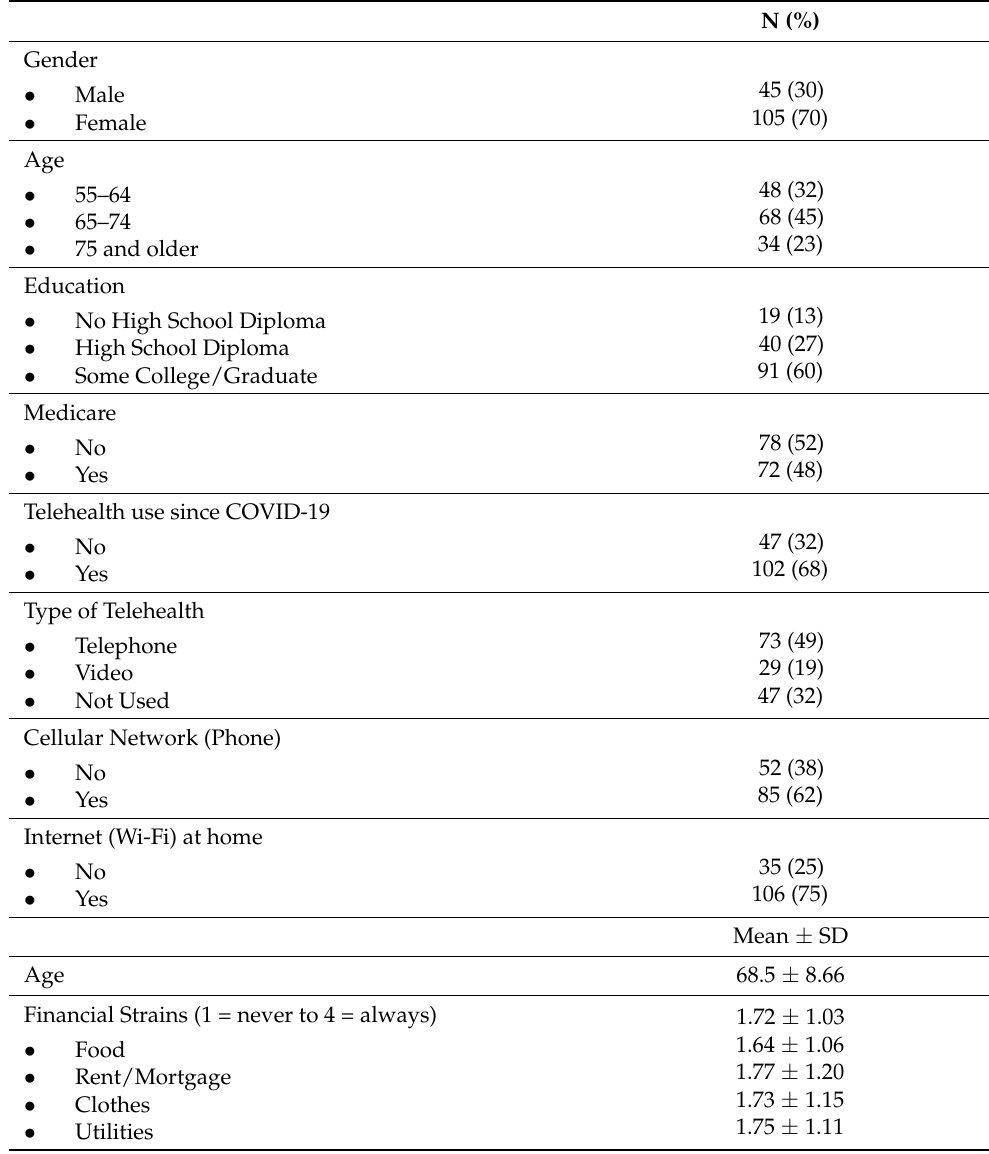
Table 1. Demographic, financial, and health-related characteristics and telehealth use among a sample of underserved, community-based, middle-aged and older African American adults (n = 150).